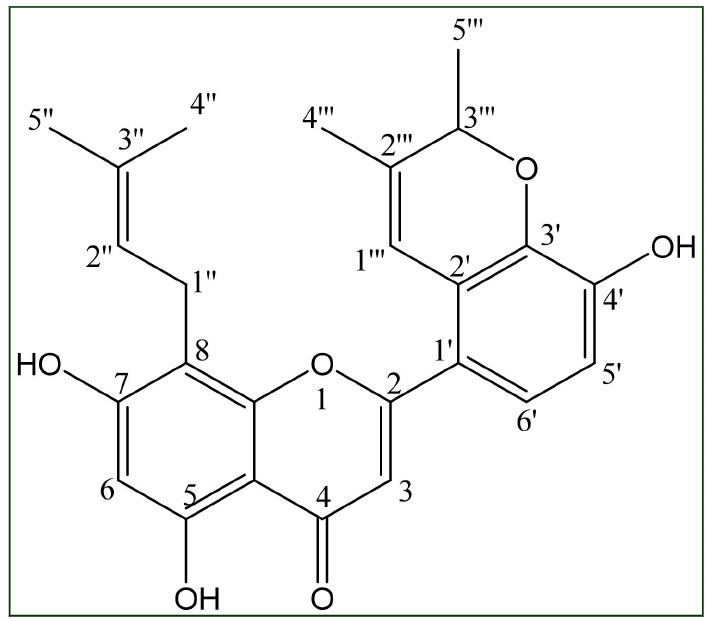
Figure 1. Morusflavone (5,7,4 (cid:48) -trihydroxy-8-( γ -methylallyl)-2 (cid:48) ,3 (cid:48) -(2 (cid:48)(cid:48)(cid:48) ,3 (cid:48)(cid:48)(cid:48) -dimethylpyr-1 (cid:48)(cid:48)(cid:48) -enyl)